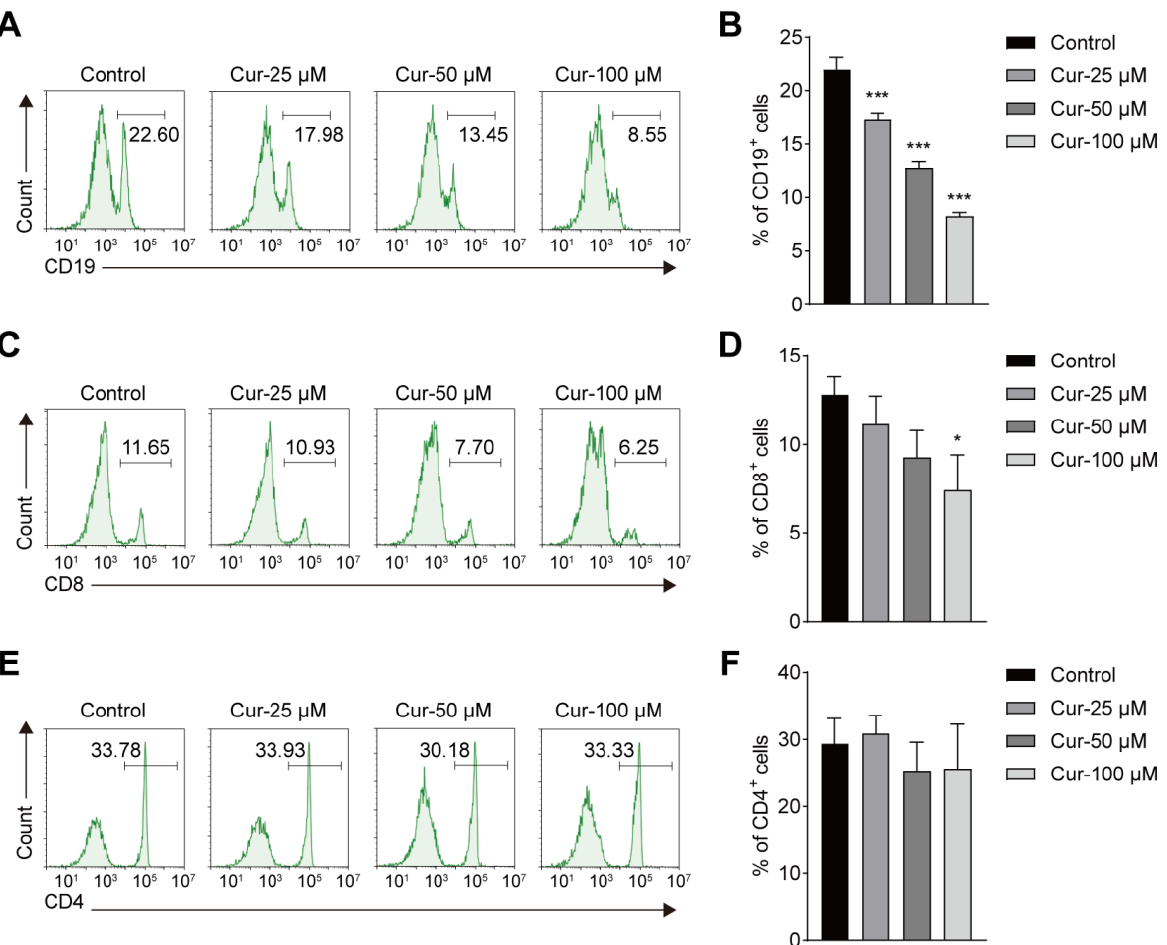
Figure 3. Effects of curcumol on CD19+, CD8+ and CD4+ immune cells in vitro. ( A,C,E ) Flow cytometry analysis of CD19 + , CD8 + and CD4 + cells at different dose of curcumol concentrations. ( B,D,F ) Percentages of CD19 + , CD8 + and CD4 + cells in peripheral blood mononuclear cells (PBMCs). The data represent the mean ± SD. * p < 0.05; *** p < 0.001.